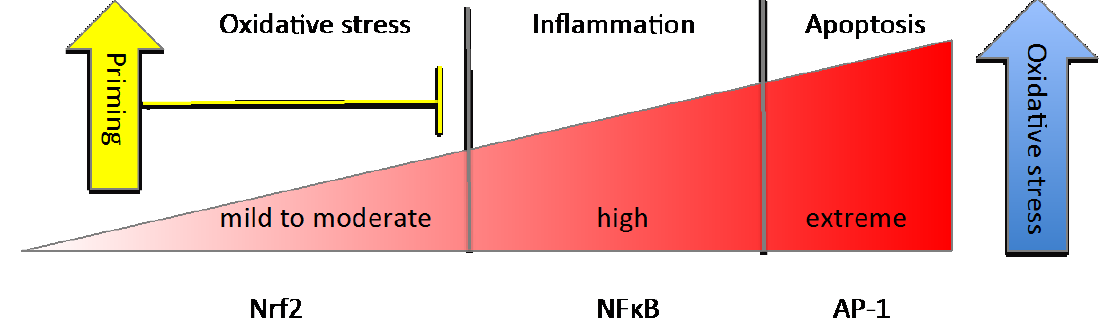
Figure 2. Differential responses to rising oxidative